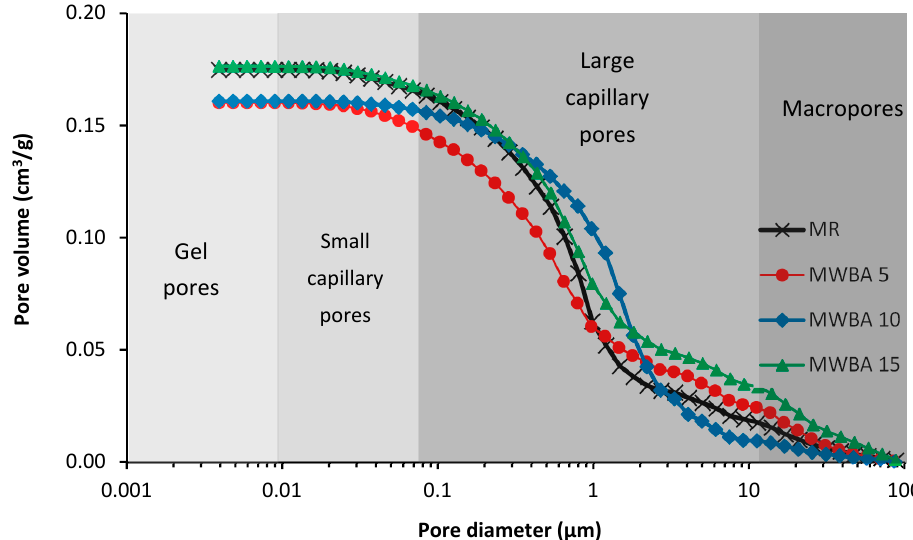
Figure 5. Pore size distribution of tested mortars: 28 day samples.